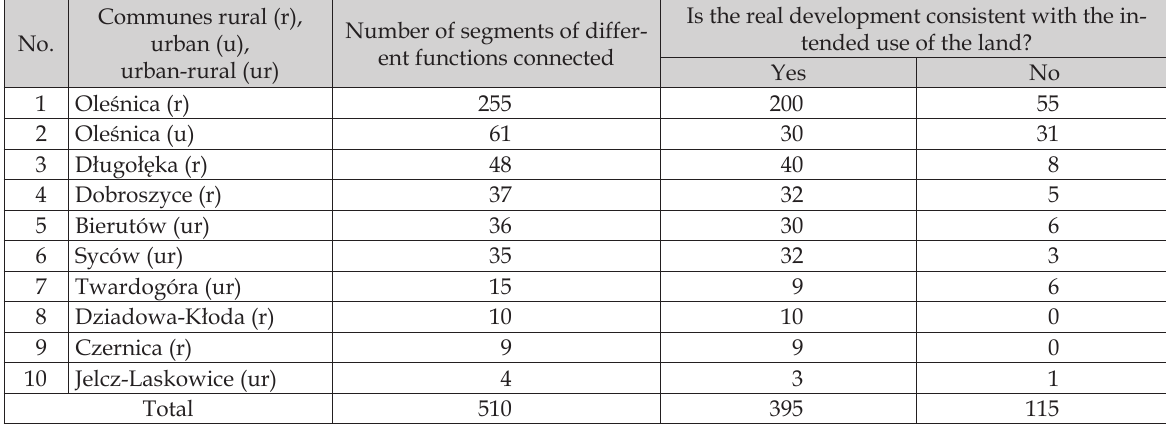
Table 3. Number of sections of consistent and inconsistent actual land use